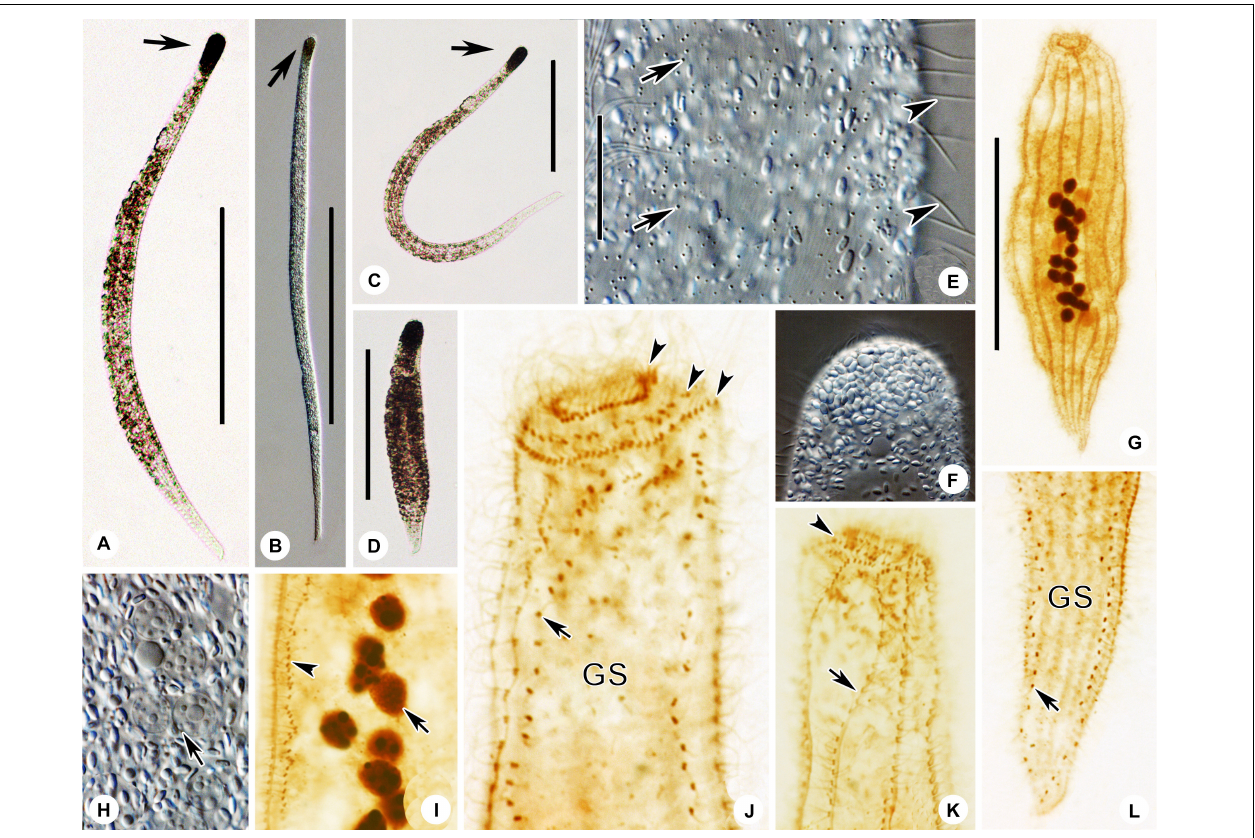
FIGURE 3 | (A–I) Paratrachelocerca typica gen. nov., spec. nov. in vivo (A–F,H) and after protargol staining (G,I–L) . (A–C) Typical individuals. Arrow showing the head of the cell. (D) An extremely contracted cell. (E) Distribution of cortical granules in glabrous stripe (arrows) and spine-like bristle cilia (arrowheads). (F) Showing head of cell packed with ellipsoidal granules. (G) Right side view of the holotype specimen showing the ciliary pattern and multiple macronuclei. (H) Showing globular macronuclei. (I) Left margin of mid-body showing macronucleus (arrow) and bristle kinety (arrowhead). (J,K) Detailed ciliature of left (J) and right (K) side of anterior body region, three circumoral kineties each composed of a row of dikinetids (arrowheads), glabrous stripe, somatic kineties (arrow in K ), and bristle kinety (arrow in J ). (L) Ciliary pattern of tail region showing glabrous stripe and bristle kinety (arrow). GS, glabrous stripe. Scale bars = 300 µ m (A–D) ; 30 µ m (E) ; 80 µ m (G) .